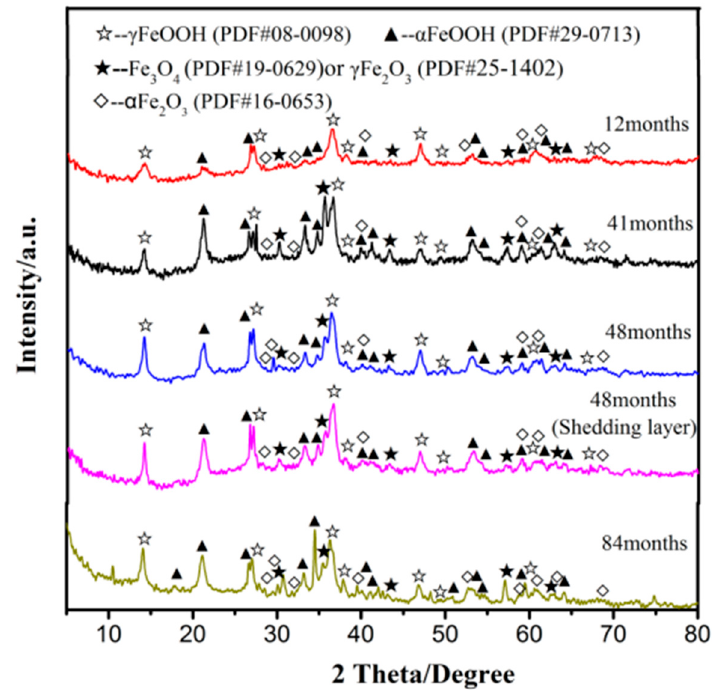
Figure 10. Structure of the rust layer phase. Table 5. Crystalline phases of corrosion products of Q235 steel formed at different